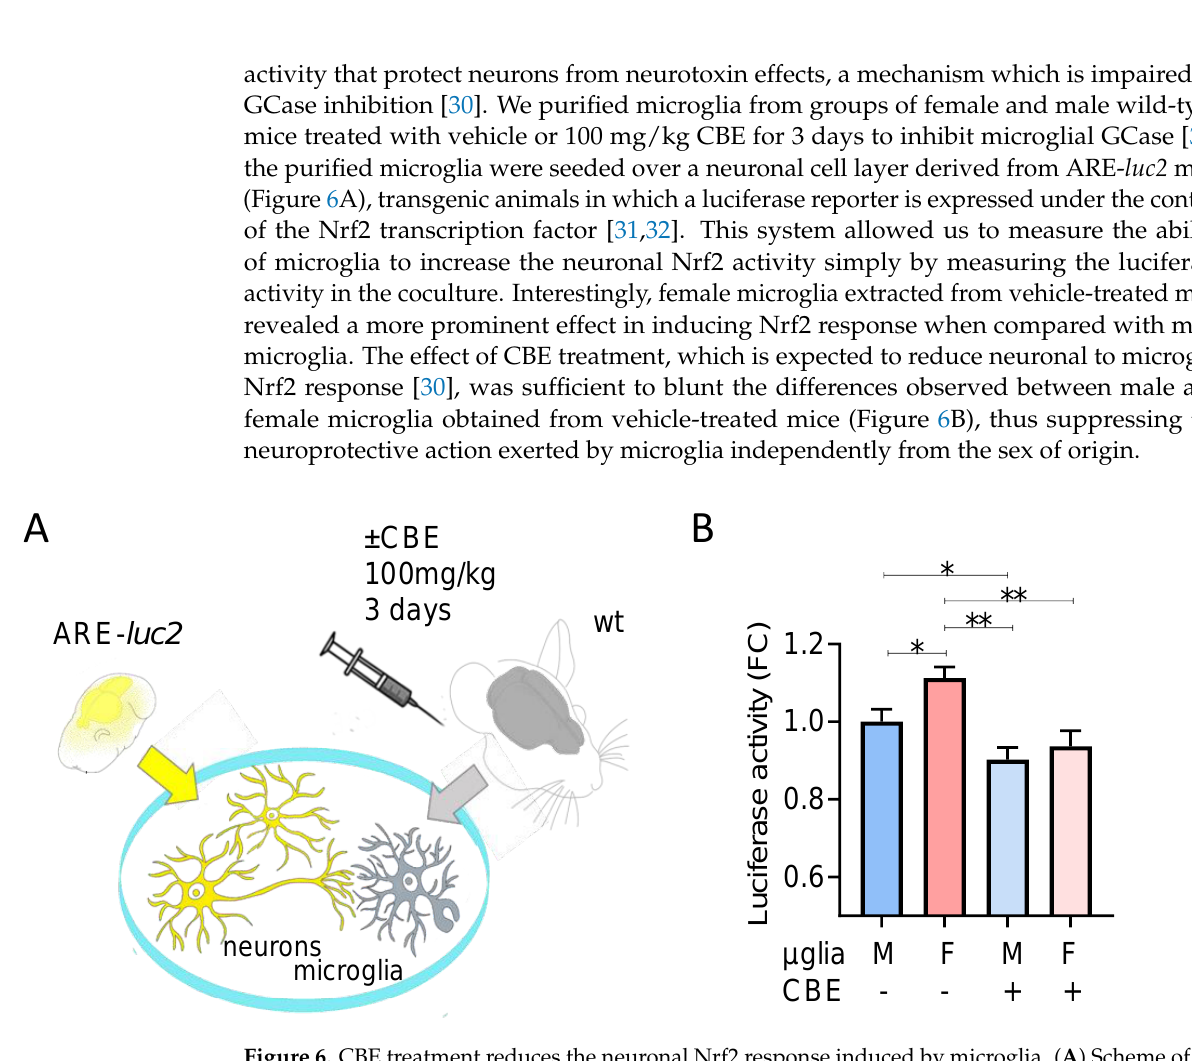
Figure 6. CBE treatment reduces the neuronal Nrf2 response induced by microglia. ( A ) Scheme of the experiments reported in B aimed at testing the effect of primary microglia ( µ glia) extracted from male or female mice treated with CBE. ( B ) Luciferase activity measured in protein extracts derived from ARE- luc2 neurons cultured with microglia derived from CBE- or vehicle-treated mice ( A ). Data are presented as mean ± SEM of n = 7 independent samples. * p < 0.05, ** p < 0.01 calculated by unpaired t -test vs. the corresponding sample.